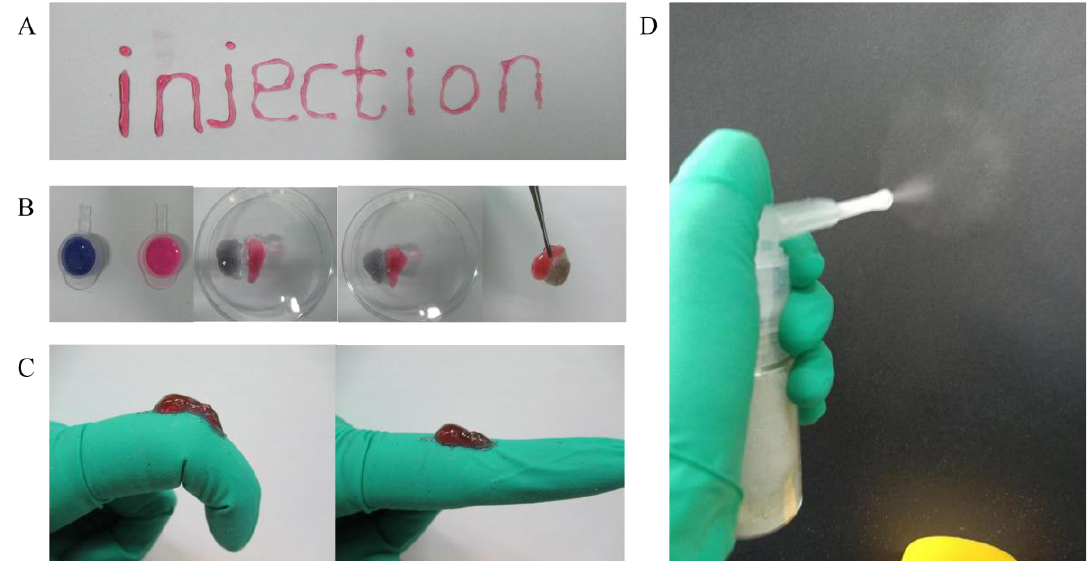
Figure 4. ( A ) The injectability, ( B ) self-healing, Red gel is the gel stained with Rhodamine B and blue gel is the gel stained with methyl blue ( C ) shape adaptation, and ( D ) spray ability of hydrogel.